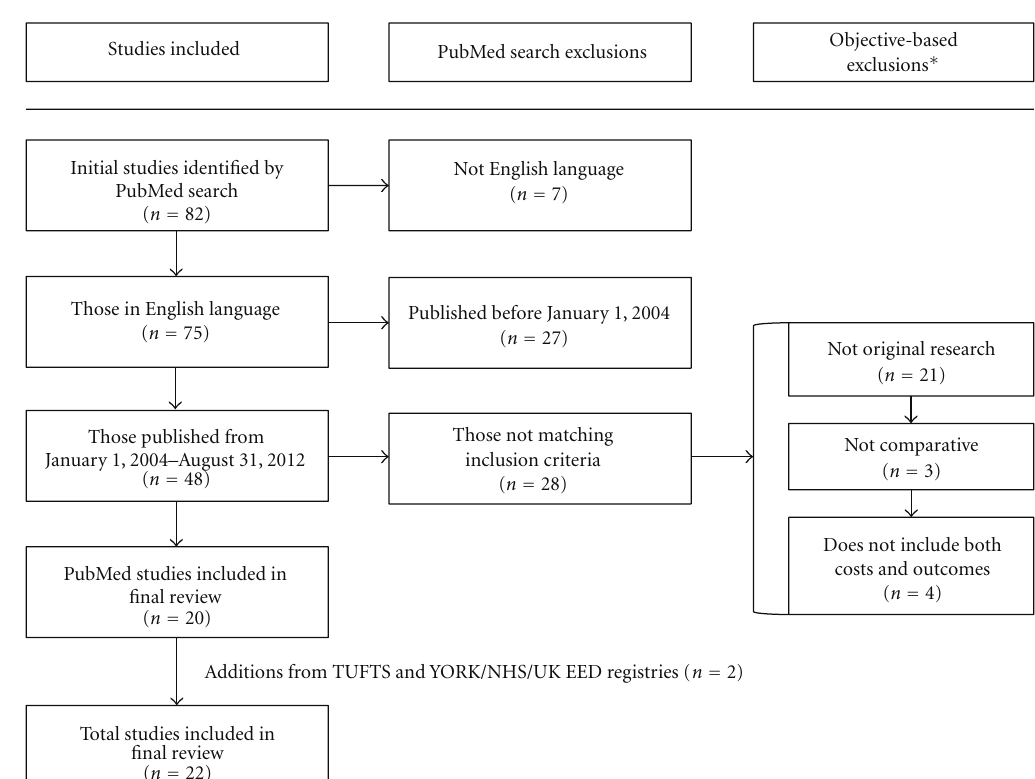
Figure 1: Flowchart of systematic search methodology and